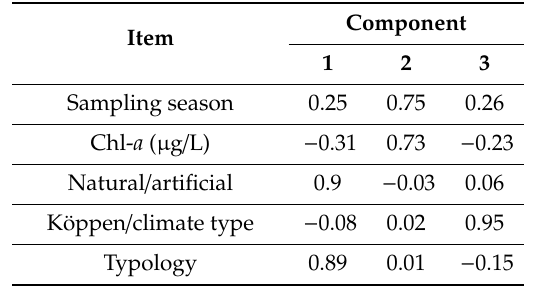
Table 6. Rotated component matrix (rotation method: Varimax with Kaiser normalization; rotation converged in five